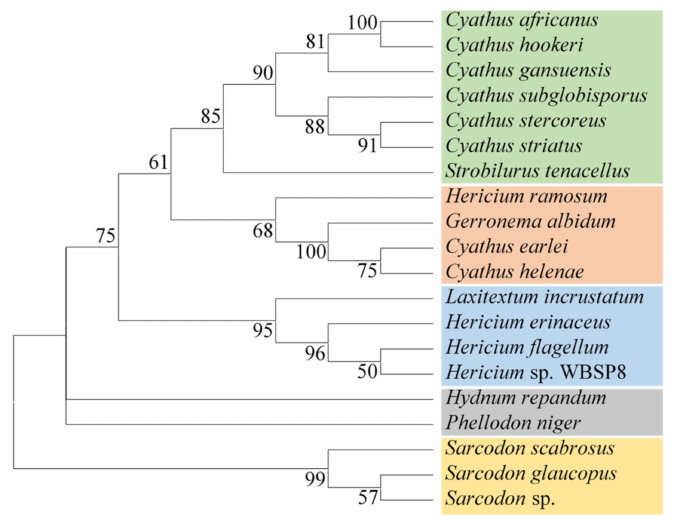
Figure 1. The evolutionary analysis tree constructed with selected fungi producing cyathane diterpenoids. The evolutionary analysis was reconstructed by the maximum likelihood method from the internal transcribed spacer (ITS) sequences as follows: Cyathus africanus (JX103204.1), C. earlei (KY964272.1), C. gansuensis (KC869661.1), C. helenae (DQ463334.1), C. hookeri (KC005989.1), C. stercoreus (MH543350.1), C. striatus (KU865513.1), C. subglobisporus (MH156046.1), Gerronema albidum (MF318924.1), Hericium erinaceus (KU855351.1), H. flagellum (MG649451.1), H. ramosum (U27043.1), H. sp. WBSP8 (MN243091.1), Hydnum repandum (LC377888.1), Laxitextum incrustatum (KT722621.1), Phellodon niger (MH310794.1), Sarcodon glaucopus (MT955152.1), S. scabrosus (MN992643.1), Strobilurus tenacellus (MF063128.1). Since the ITS sequence of Sarcodon cyrneus was not available, Sarcodon sp. (MK049936.1) was selected, since it is in the same family with S. cyrneus . The evolution- ary history was inferred by using the maximum likelihood method and the general time reversible model [62]. The bootstrap consensus tree inferred from 1000 replicates is taken to represent the evolu- tionary history of the taxa analyzed [63]. Branches corresponding to partitions reproduced in less than 50% bootstrap replicates are collapsed. The percentage of replicate trees in which the associated taxa clustered together in the bootstrap test (1000 replicates) are shown next to the branches [63]. Initial tree(s) for the heuristic search were obtained automatically by applying the Neighbor-Join and BioNJ algorithms to a matrix of pairwise distances estimated using the maximum composite likelihood (MCL) approach, and then selecting the topology with superior log likelihood value. A discrete Gamma distribution was used to model evolutionary rate differences among sites (5 categories (+ G , parameter = 1.2219)). The rate variation model allowed for some sites to be evolutionarily invariable ([+ I ], 0.00% sites). This analysis involved 20 nucleotide sequences. Codon positions included were 1st + 2nd + 3rd + noncoding. There were 924 positions in the final dataset. The evolutionary analysis was conducted in MEGA X (version 10.2.2)